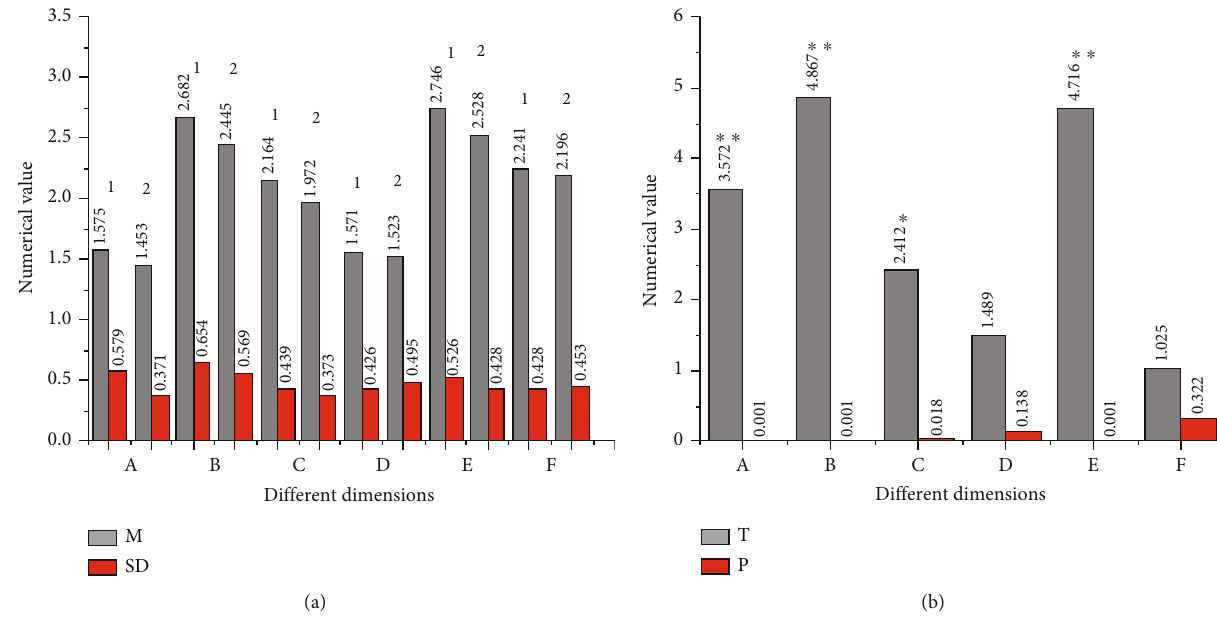
Figure 8: Comparison results of parenting styles of college students of di ff erent genders: (a) mean and standard deviation of descriptive statistics; (b) t values and P values for descriptive statistics; 1: boys; 2: girls; A: father ’ s rejection; B: father ’ s emotional warmth; C: father ’ s overprotection; D: mother ’ s rejection; E: mother ’ s emotional warmth; F: mother ’ s overprotection; ∗∗ P < 0 : 01 ; ∗ P < 0 : 05